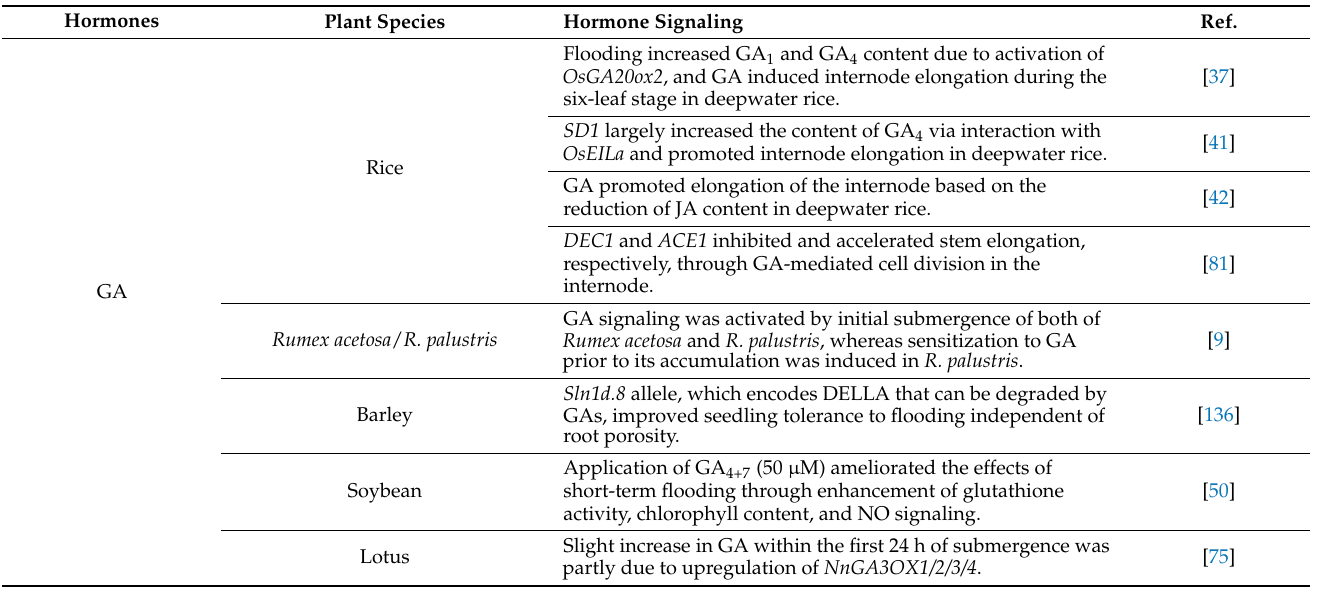
Table 4. Effects of GA, auxin, BR, JA, and SA in plants during flooding